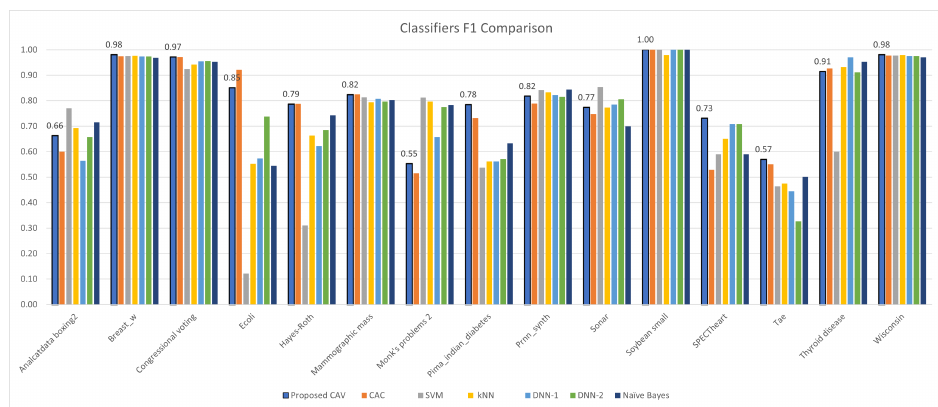
Figure 11. CAV with other classifiers; F1 comparison for the test